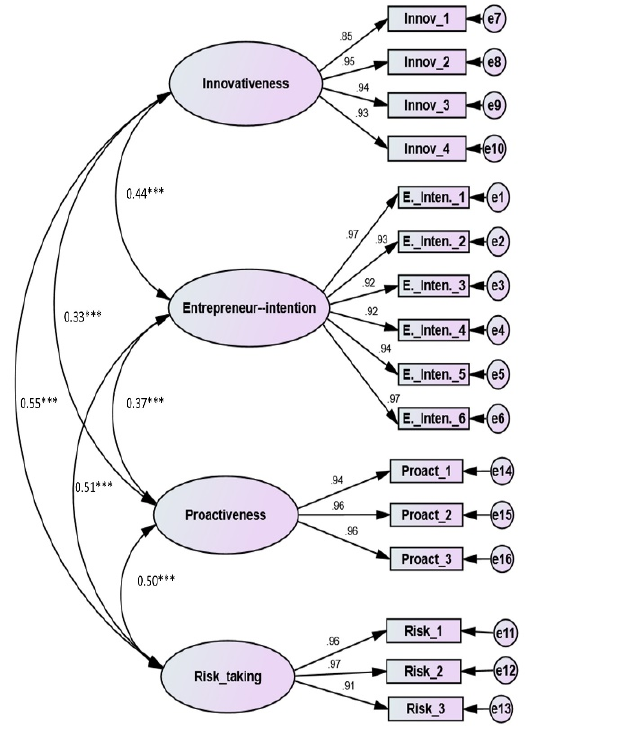
Figure 2. CFA Model, ***: significant level below 0.001.